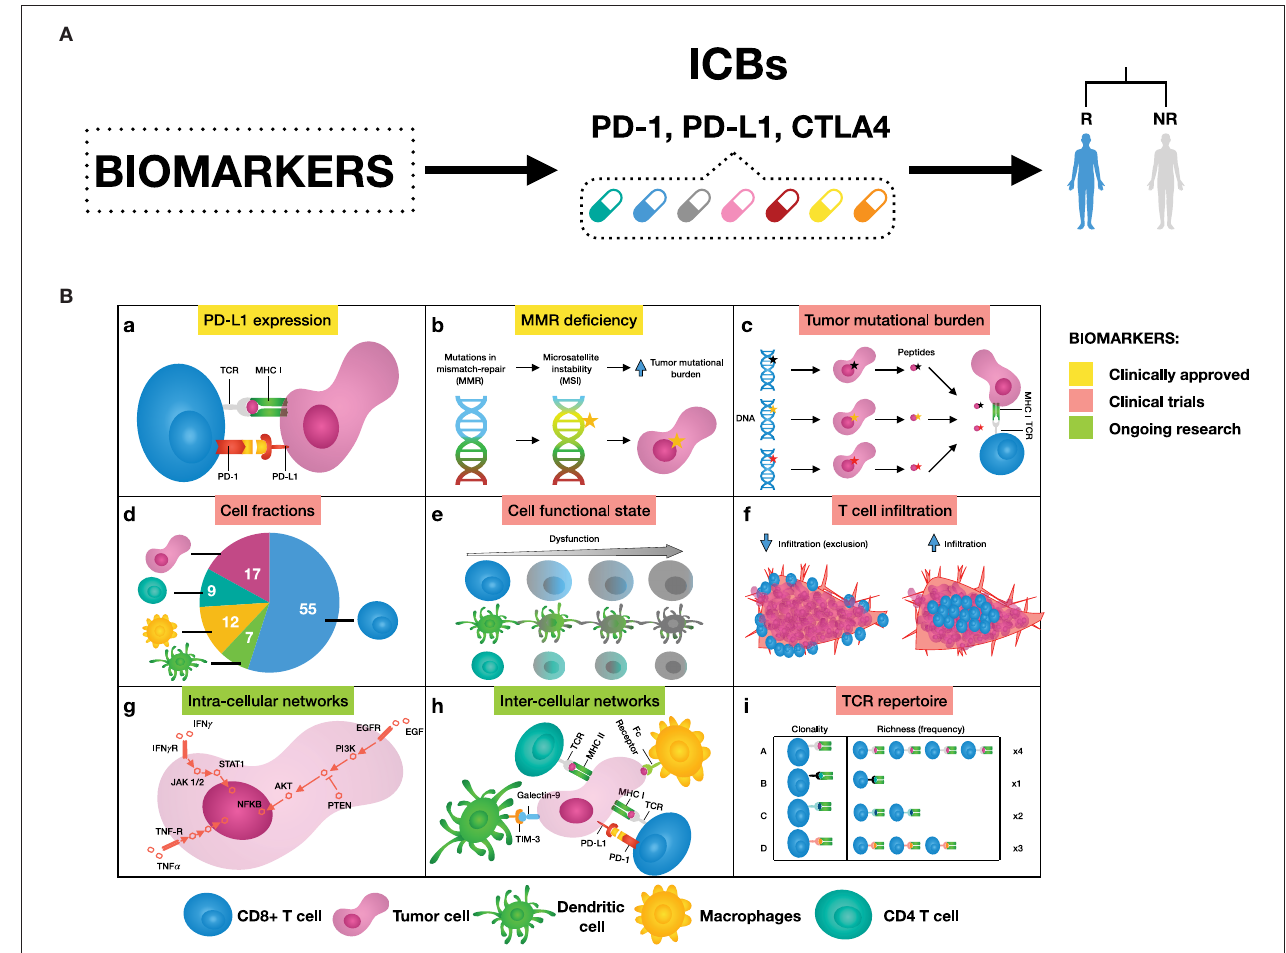
FIGURE 1 | (A) Biomarkers can help to select patients that are likely to respond to immune checkpoint blockers (ICBs), leaning toward personalized immuno-oncology. (B) Examples of possible mechanisms that can inform on response to ICBs. (a) Binding of PD-L1 to PD-1 transmits an inhibitory signal that reduces the proliferation of T cells and can induce apoptosis. (b) Genetic alterations in MMR proteins produce a large number of mutations leading to a large number of mutations that generate neoantigens. (c) The number of non-synonymous single nucleotide variants in a tumor, known as the tumor mutational load, may affect the generation of neoantigens influencing the T cell response. (d) Quantification of different immune cell types offers a new opportunity to assess treatment efficacy. (e) Immune cells can be in a dysfunctional state, therefore promoting tumor immune escape. (f) The degree of T cell infiltration can affect ICBs effectiveness. (g) Signaling pathways are responsible for the correct functioning of the cells. Cancer is caused by deregulations in these cellular signaling pathways, ultimately changing the cell phenotype. (h) There are a great number of pathways and cross-talks involved in the communication between tumor and immune cells. (i) Both, all sorts of TCR sequences and the richness of each specific TCR sequence, can deal with the wide variety of neoantigens expressed by tumor cells. As a result, more specific T cell clones are present, and therefore ready to mount an effective T cell response.